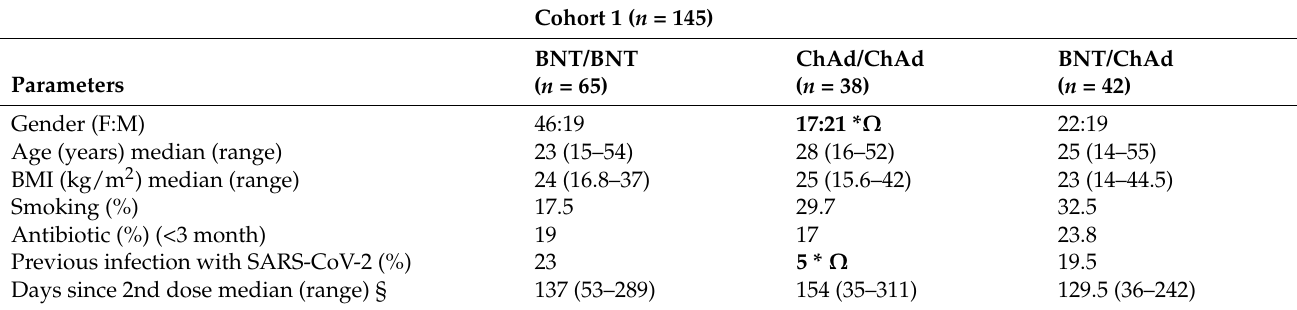
Table 1. Demographics of Cohort 1 Study Participants.